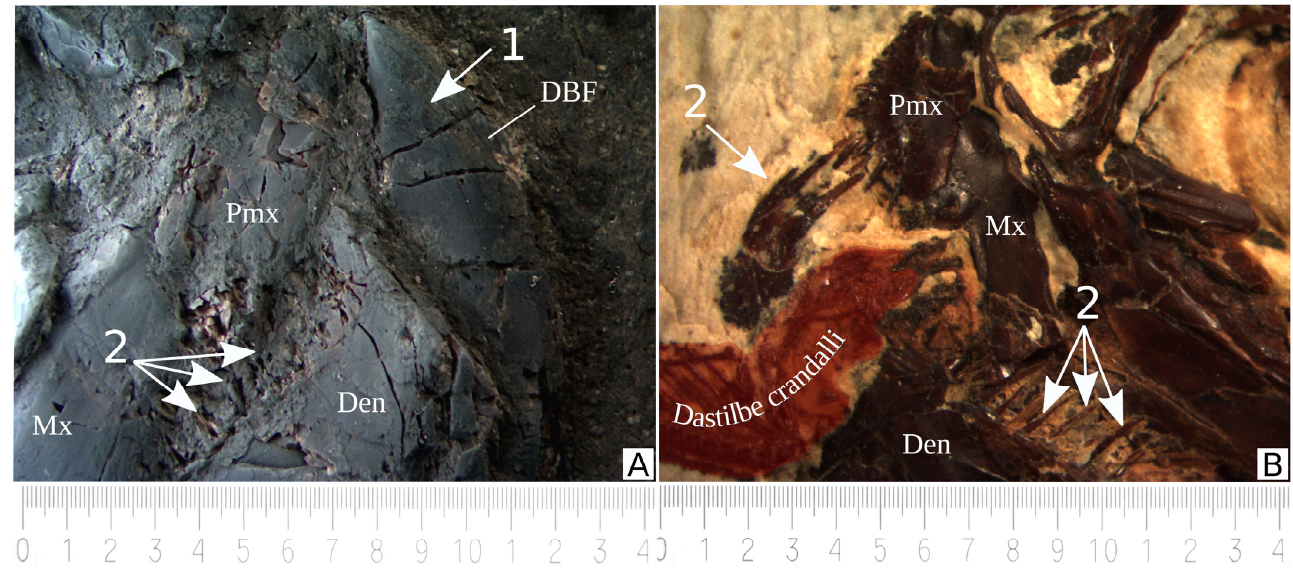
Figure 7. Anterior jaw area in † Cladocynodon araripensis sp. nov. ( A ) (CFUFMT 139; holotype, anterior to right) and ( B ) † Cladocyclus gardnerii (CFUFMT 87, Crato Formation, anterior to left). Arrows indicate anterior enlarged dentary bone fang ( DBF ) (1), followed by smaller posterior true teeth (2). † Cladocyclus gardnerii has only typical teeth of similar size (2). A small † Dastilbe crandalli is observed in the mouth of † Cladocyclus gardnerii , but it is not possible to conclude that it is due to predation or represents an aleatoric association.